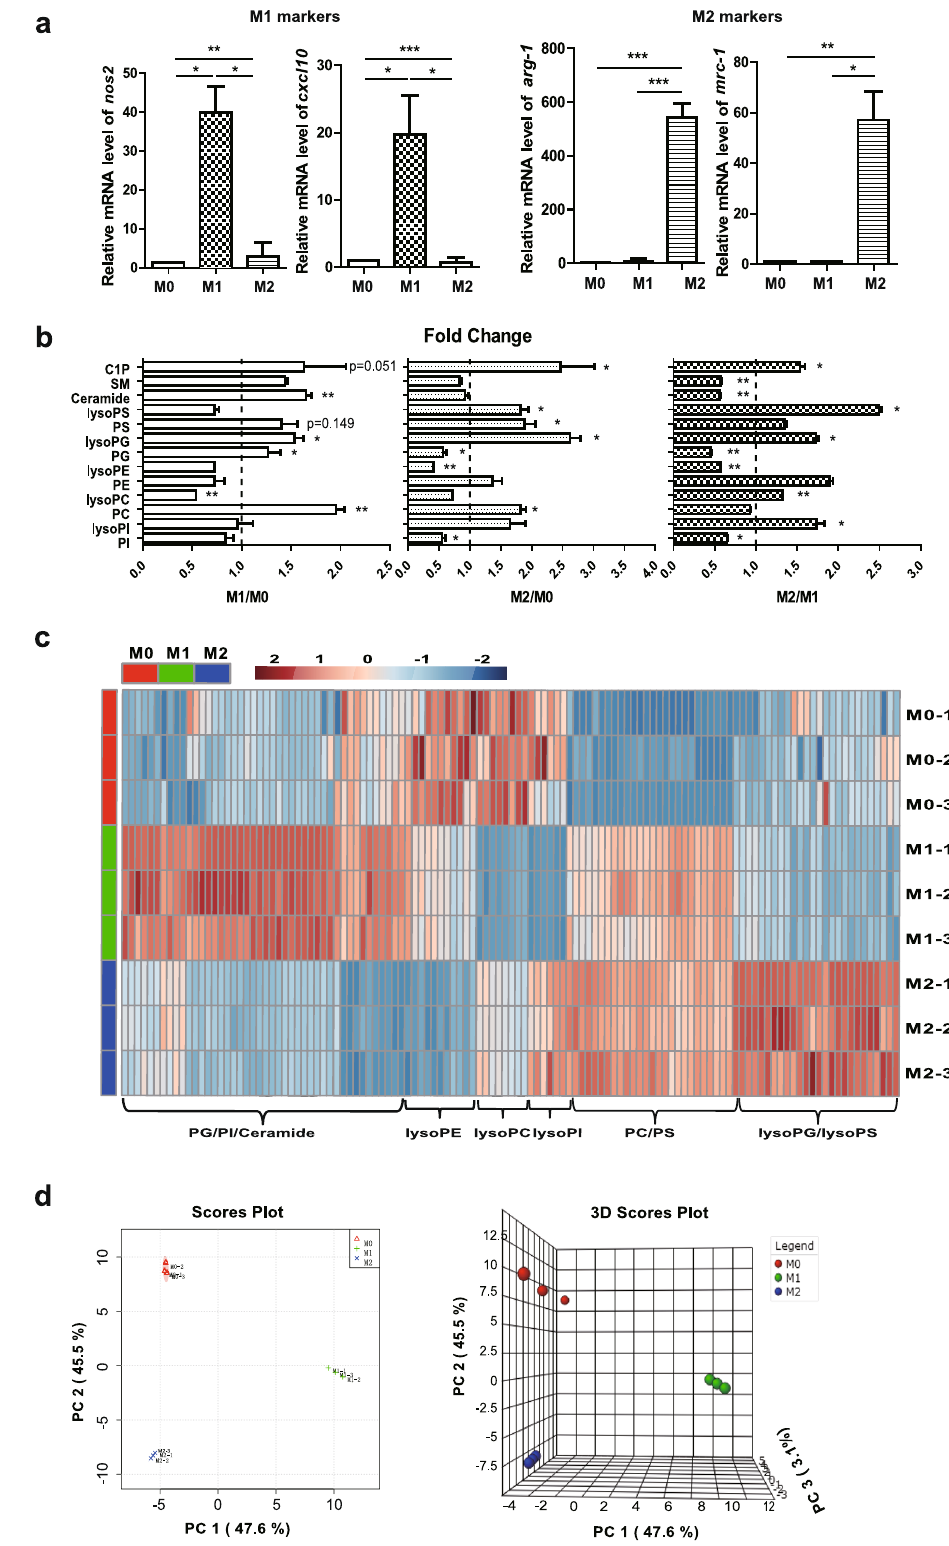
Figure 4. Most glycerophospholipids and lysophospholipids are increased in mouse activated macrophages. ( a ) From left to right, the expression levels of nos2 , cxcl10 , arg-1 , and mrc-1 were analyzed to assess the polarization into M1 and M2 macrophages. The data represent the mean ± SEM, n = 3, * p < 0.05, ** p < 0.01, *** p < 0.001. ( b,c ) Histogram and clustering analysis show a comparison of the lipid classification between the two groups. Most glycerophospholipids and lysophospholipids were elevated in activated macrophages. Ceramide and ceramide-1-phosphate were also increased in activated cells. ( d ) PCA suggested that three types of macrophages could be separated from each other in 2D and 3D score